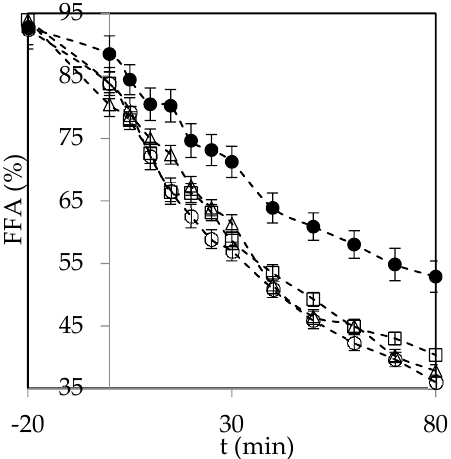
Figure 1. Time course of esterification of linoleic acid with stoichiometric ( ● ), 20% excess ( ∆ ), 40% excess ( □ ), and 80% excess ( ○ ) glycerol (mean ± SD, n = 2).